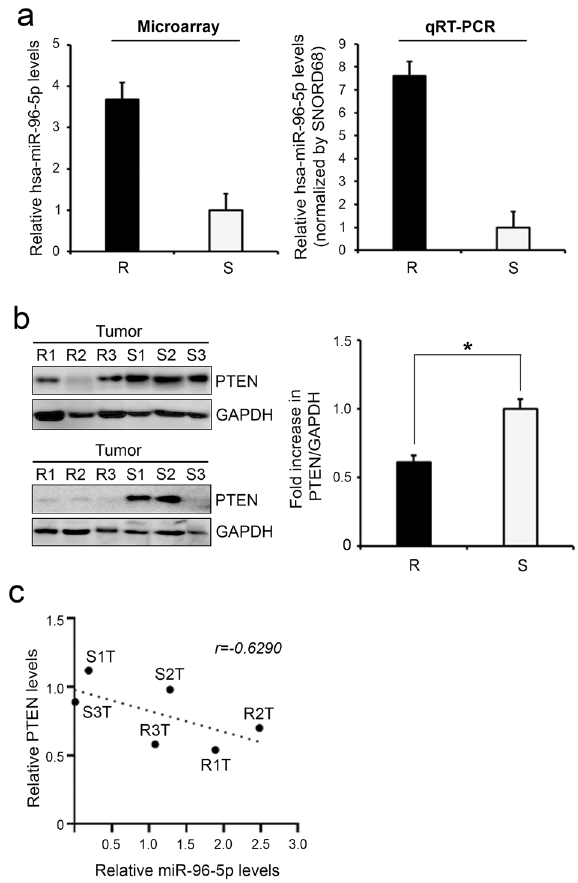
Figure 2. Expression levels of miR-96-5p and PTEN in patient samples. ( a ) The fold changes detected by microarray are denoted in a bar graph. Real-time RT-PCR validation of the miR-96-5p expression levels in the same patient samples used in the microarray. ( b ) Western blot (left) and quantification (right) of PTEN proteins in tumor tissues from sunitinib-resistant (R1, R2, and R3) and sunitinib-sensitive (S1, S2, and S3) CCRCC patients. Samples were collected from two different regions of tumors. GAPDH was used as a loading control. Data are presented as mean ± s.e.m. (n = 3). Significant results are presented as * P < 0.01. ( c ) The levels of miR- 96-5p determined by qRT-PCR in fresh frozen tissue were compared with the corresponding PTEN proteins determined by Western